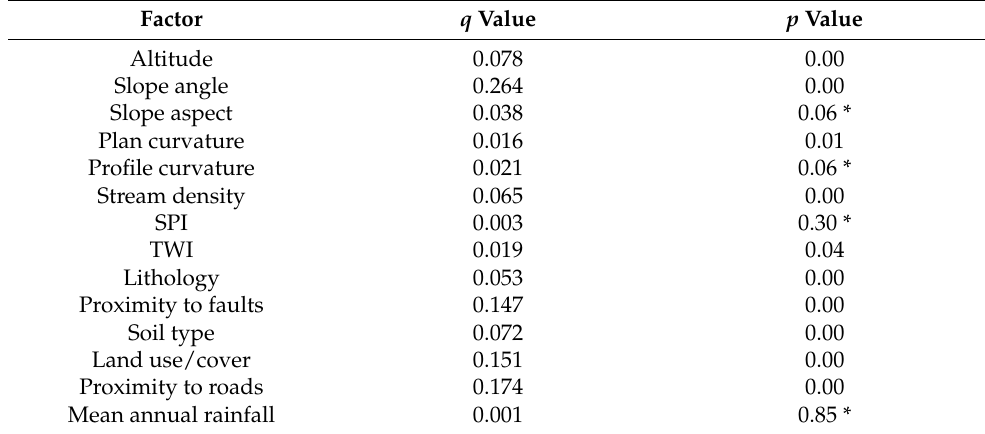
Figure 4. Conditioning factors: ( a ) altitude; ( b ) slope angle; ( c ) slope aspect; ( d ) plan curvature; ( e ) profile curvature; ( f ) stream density; ( g ) SPI; ( h ) TWI; ( i ) lithology; ( j ) proximity to faults; ( k ) soil type; ( l ) mean annual rainfall; ( m ) land use/cover; ( n ) proximity to roads. Table 4. The q and p -statistic values for the conditioning factors, calculated using